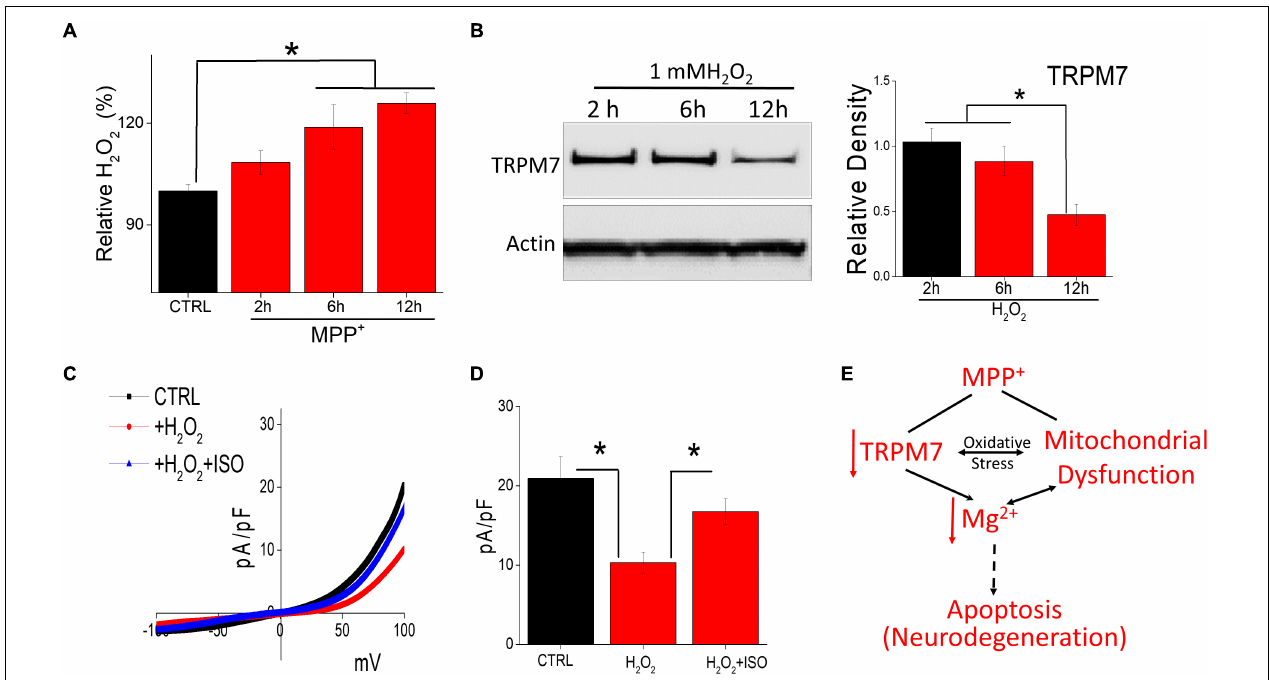
FIGURE 5 | Oxidative stress induced by neurotoxin treatment inhibits TRPM7 expression/function: (A) Relative H 2 O 2 release was evaluated under various conditions (MPP + -treated 500 µ M) in SH-SY5Y cells. The columns show the means ± SEM of 4 experiments. (* p < 0.05, ** p < 0.01; One-way ANOVA, Tukey post hoc test). (B) Western blots showing the expression of TRPM7 and loading control β -actin in CTRL and H 2 O 2 -treated (1 mM) in SH-SY5Y cells. (C) IV curves of TRPM7 currents under conditions as labeled in the figure, which are quantitation as current density at ± 100 mV [mean ± SD of 6 experiments (** p < 0.01)] are shown in (D) . (E) Proposed model for the role of TRPM7 in MPP + mediated cell